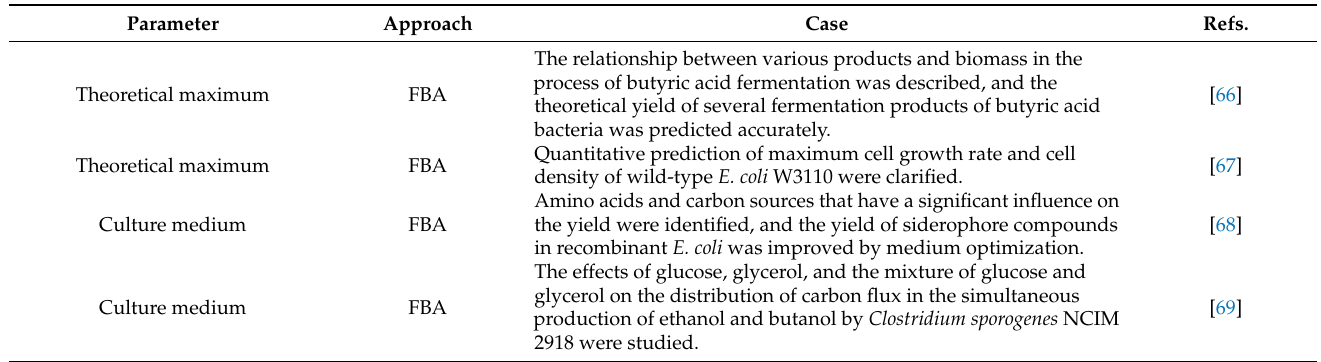
Table 2. Overview of CBM applications for the analysis and optimization of the fermentation parameters demonstrated in this